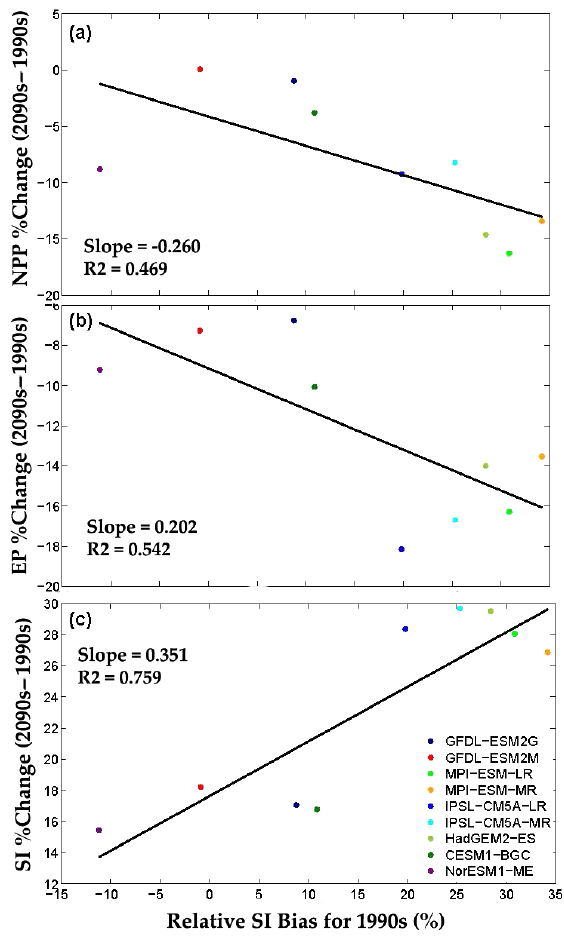
Figure 12. The stratification bias for the 1990s is plotted for each model vs. the relative changes in NPP (a) , EP (b) and stratification (c) with climate change (2090s–1990s). All three linear regressions are statistically significant at a level